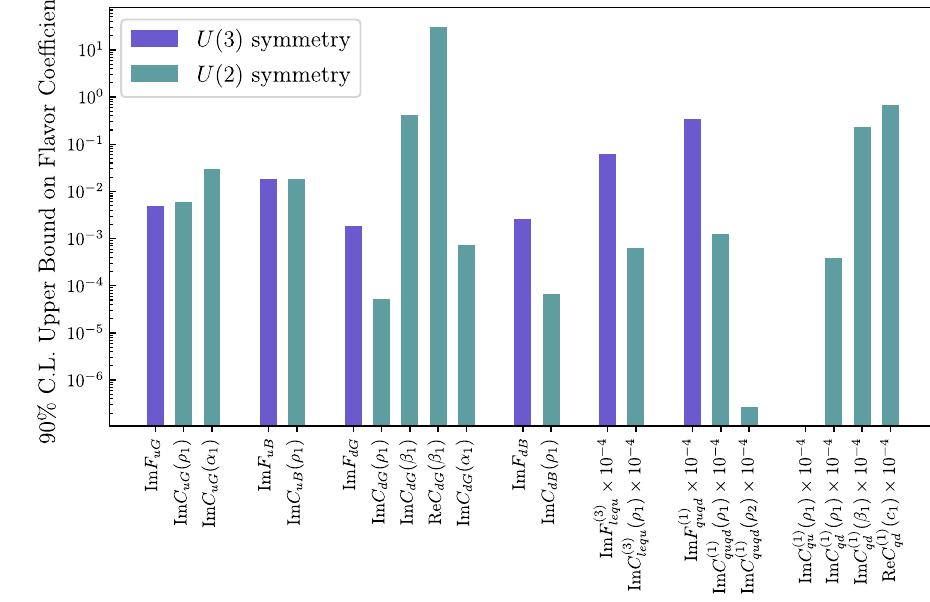
Fig. 7 Selected bounds on coefficients in spurionic expansion assuming the different flavor symmetries and for (cid:2) = 5